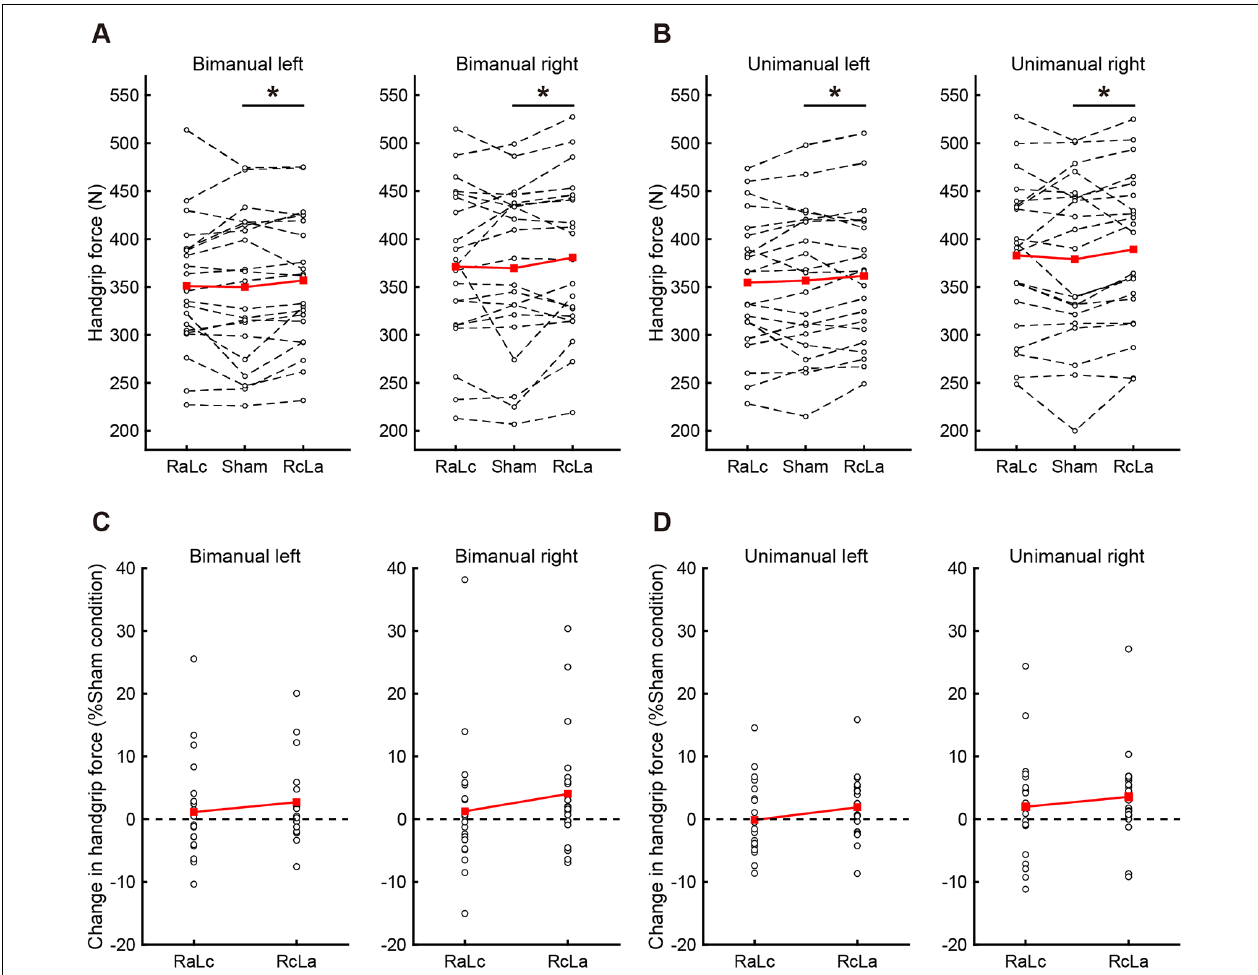
FIGURE 2 | The top figures indicate individual maximal handgrip force for (A) bimanual and (B) unimanual tasks. White circles and dashed lines show individual data, while red squares and solid lines show the averaged data. The bottom figures indicate the change in (C) bimanual and (D) unimanual handgrip strength relative to the Sham condition, and positive values indicate greater handgrip strength. White circles show individual data, while red squares and solid lines show the averaged data. Data were averaged across Test 1 and Test 2 in each task. RaLc, the anode on the right primary motor cortex (M1) and the cathode on the left M1; RcLa, the anode on the left M1 and cathode on the right M1. * p < 0.05.